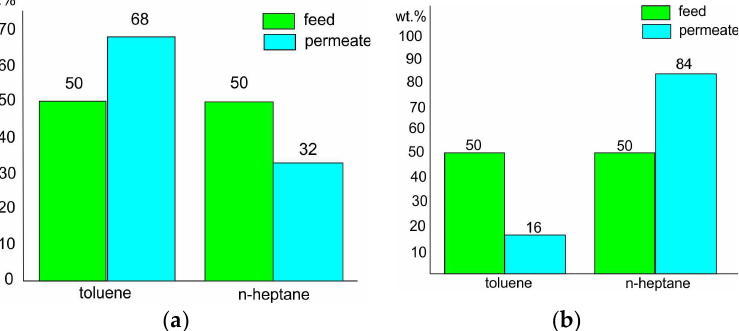
Figure 8. Comparison of transport properties of non-porous pervaporation membranes based on